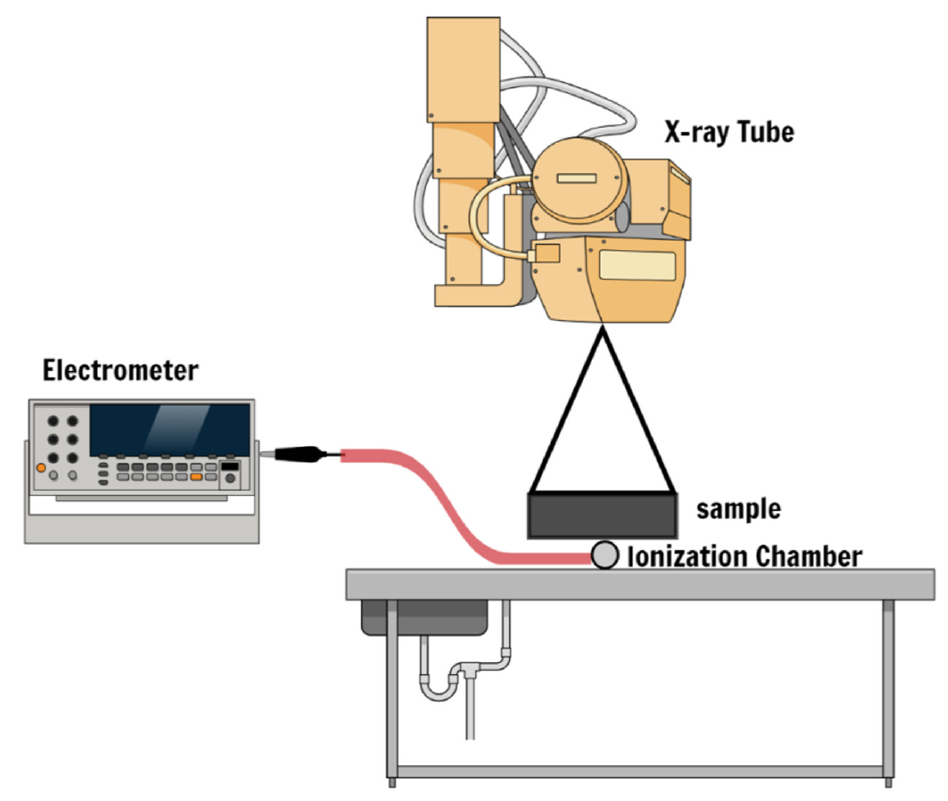
Figure 2. Schematic diagram illustrating the general set-up.